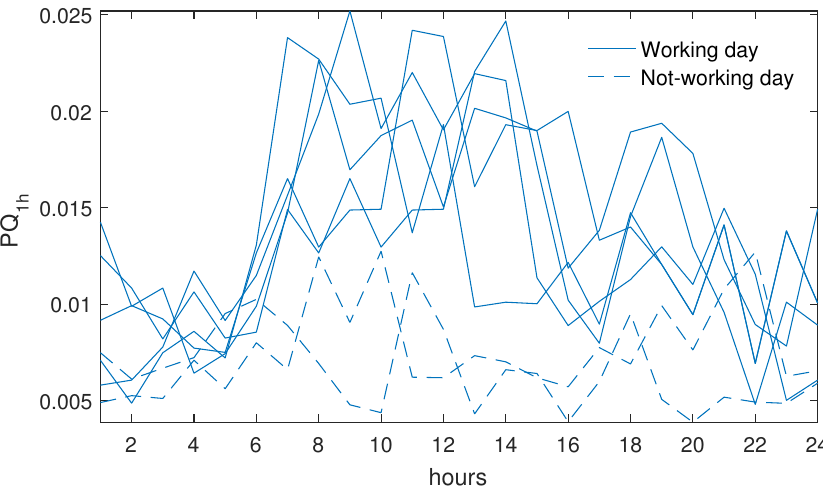
Figure 5. PQ tendency during 24 h, considering the whole week. Each PQ value is the result of an averaging of individual PQ-cycle measurements during one